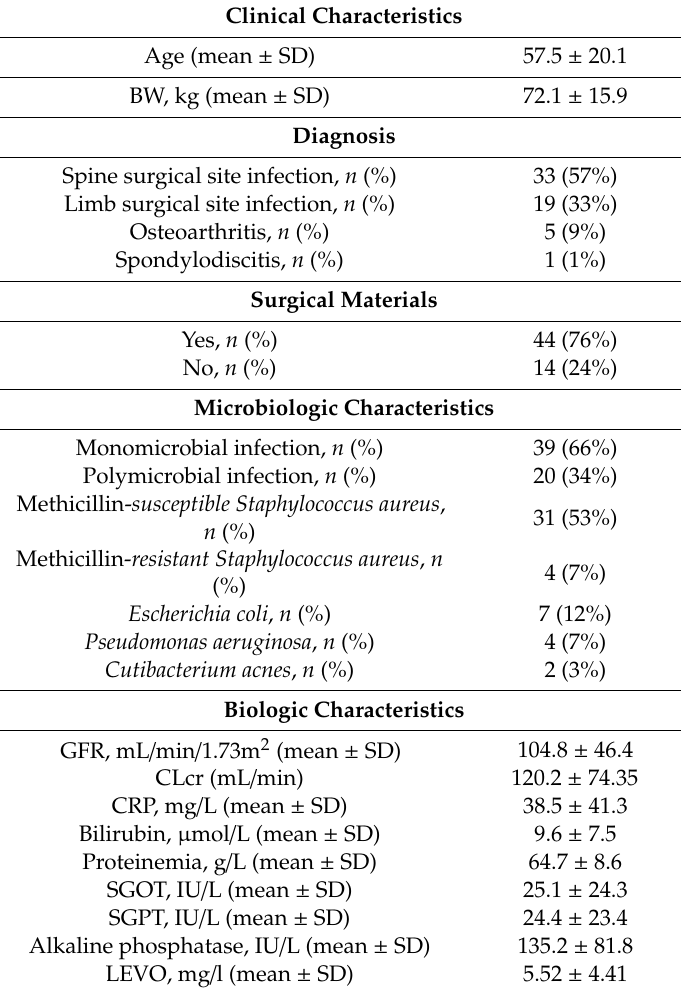
Table 1. Physiological parameters of the